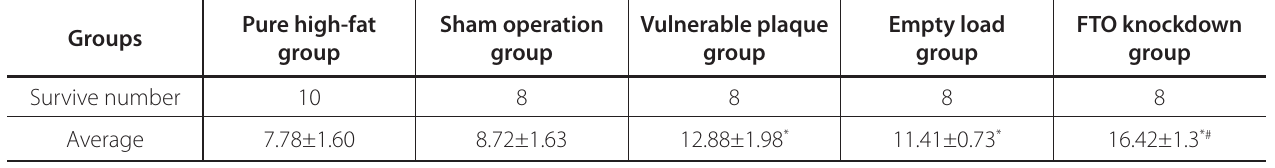
Table 2 . IL-7 level in the five groups at the 12 th week. Groups